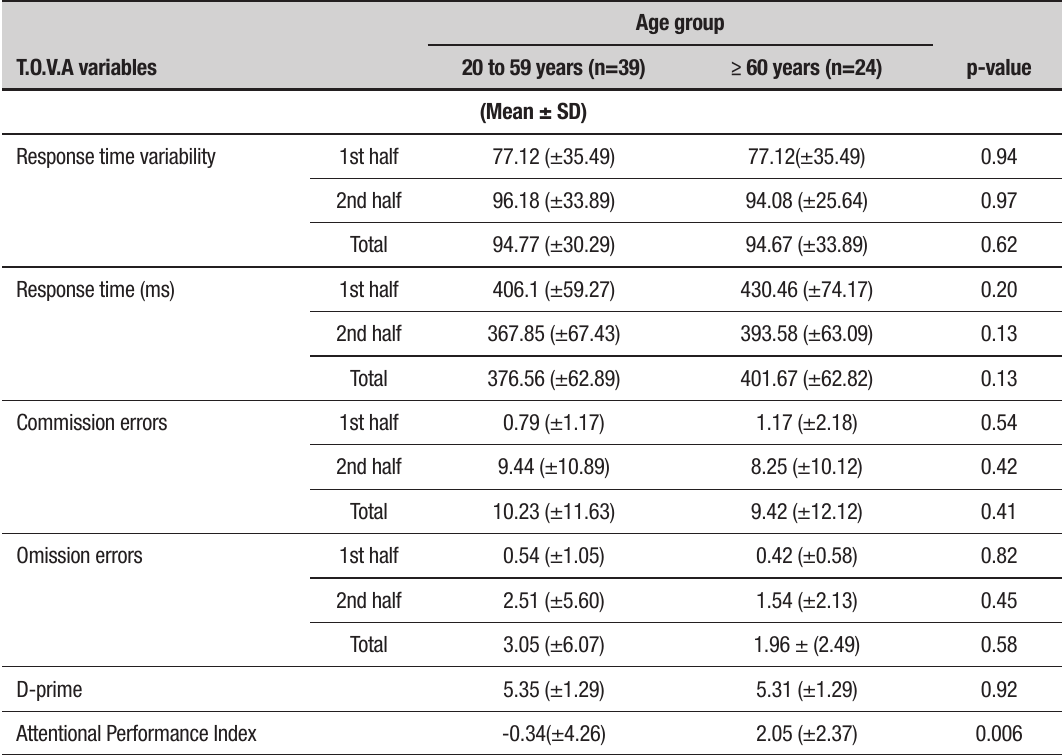
Table 3. Performance on T.O.V.A variables by age group